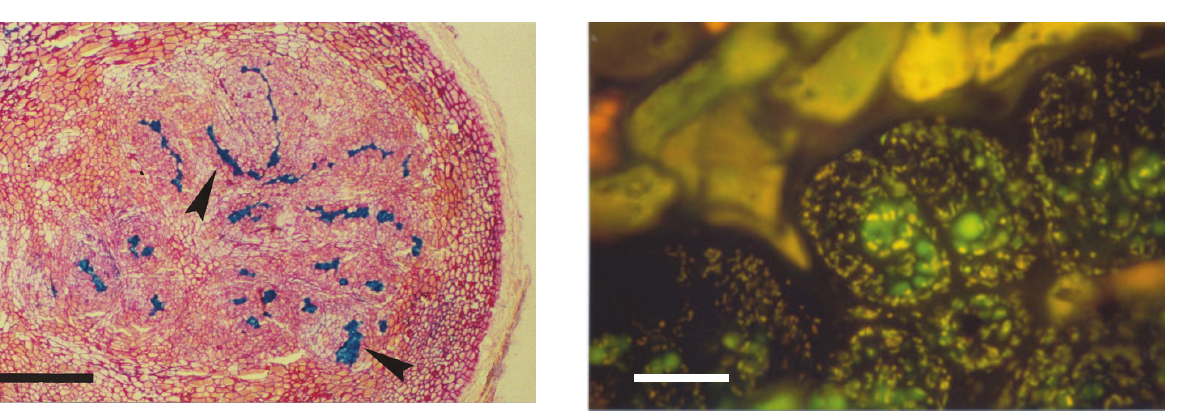
Fig. 5. Bacterial cells organized in zoogleae. Bar = 10 μ m ( fl uorescent